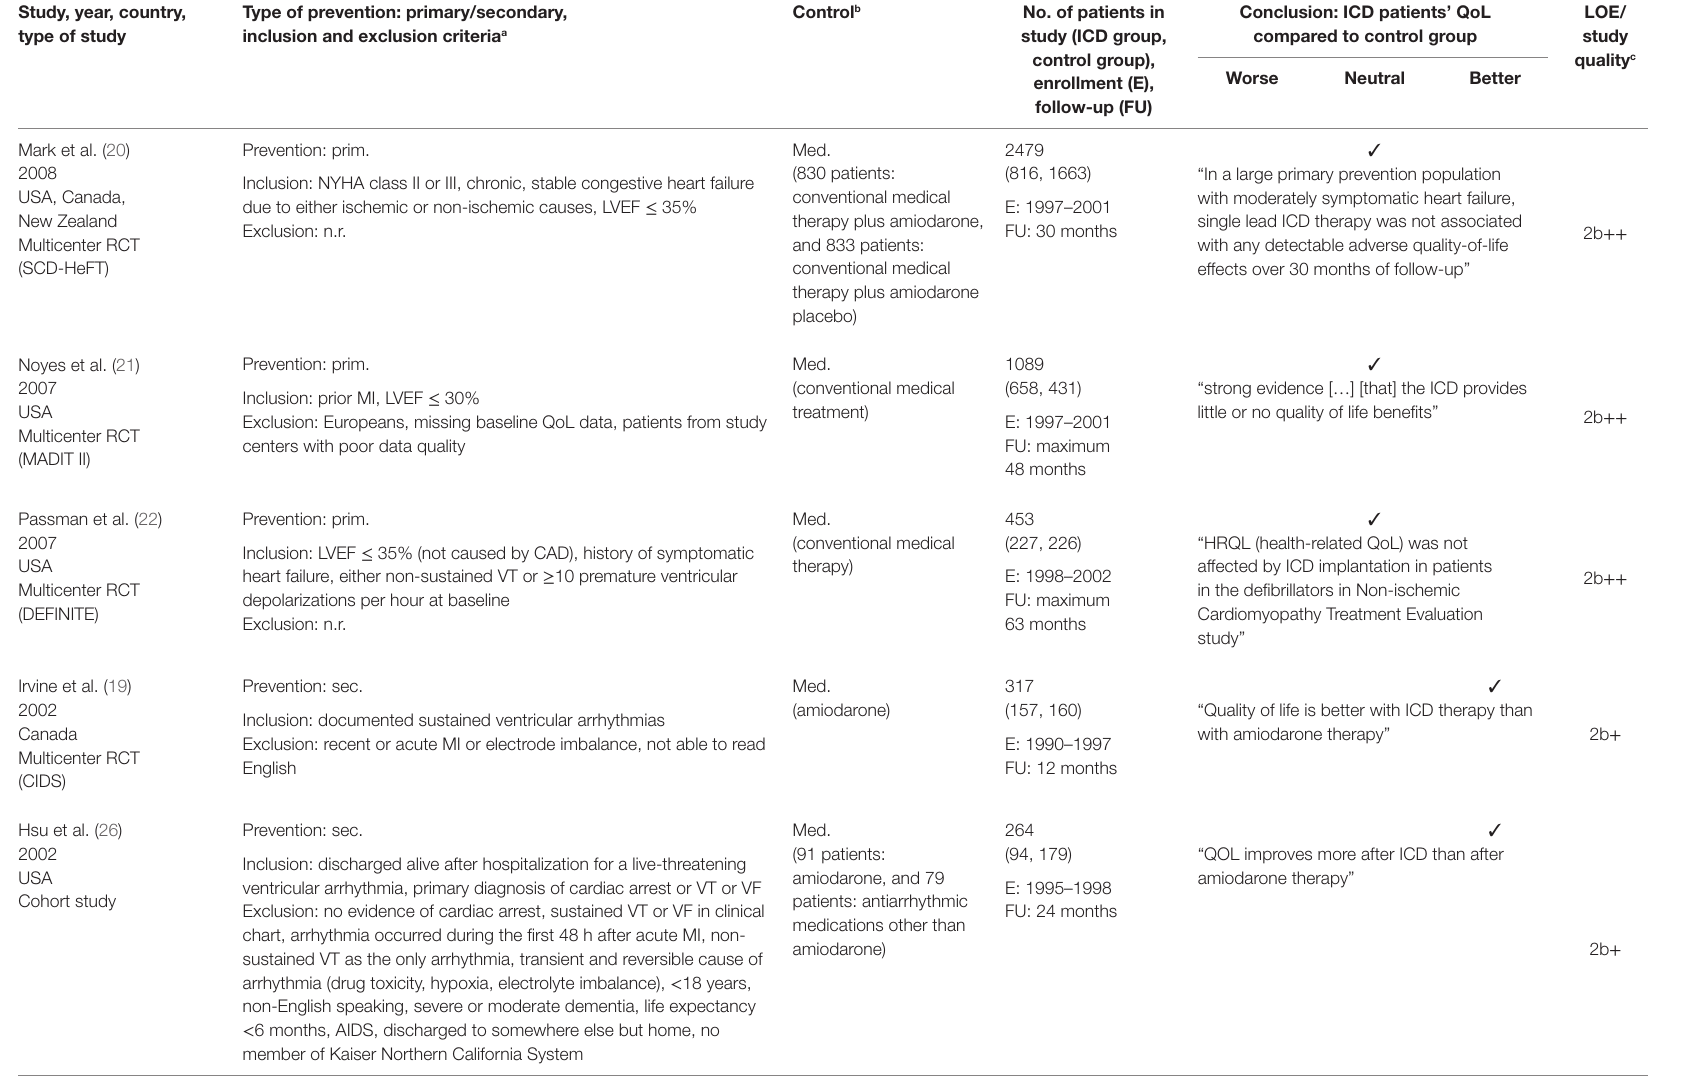
TABLe 3 | Characteristics and primary results from the included studies. Study, year, country, Type of prevention: primary/secondary, type of study inclusion and exclusion criteria